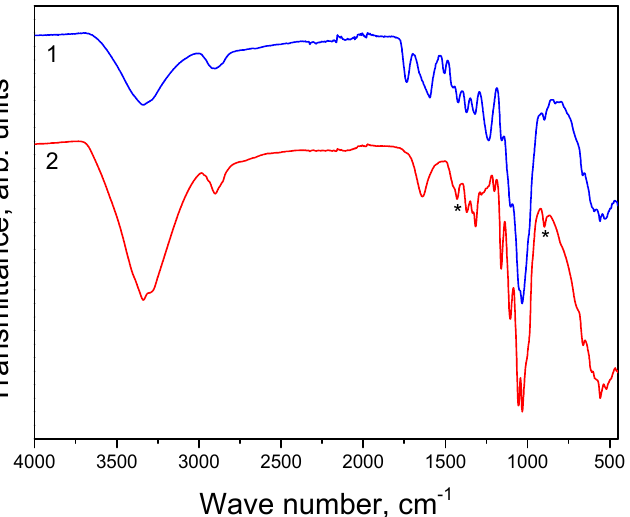
Figure 2. IR spectra of the powder were obtained by grinding dry hogweed stems (1) and HogC (2). The * sign marks the absorption bands at 1430 and 893 cm -1 (see below).